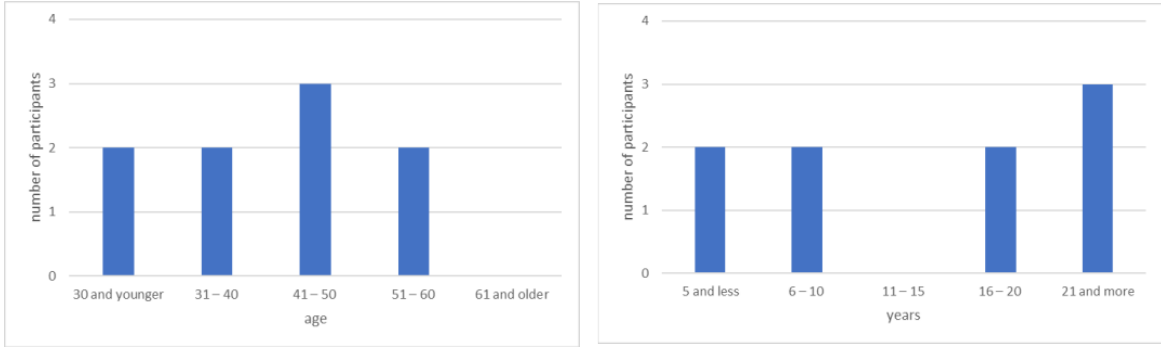
Figure 1. Age distribution and professional experience of the participating controllers.